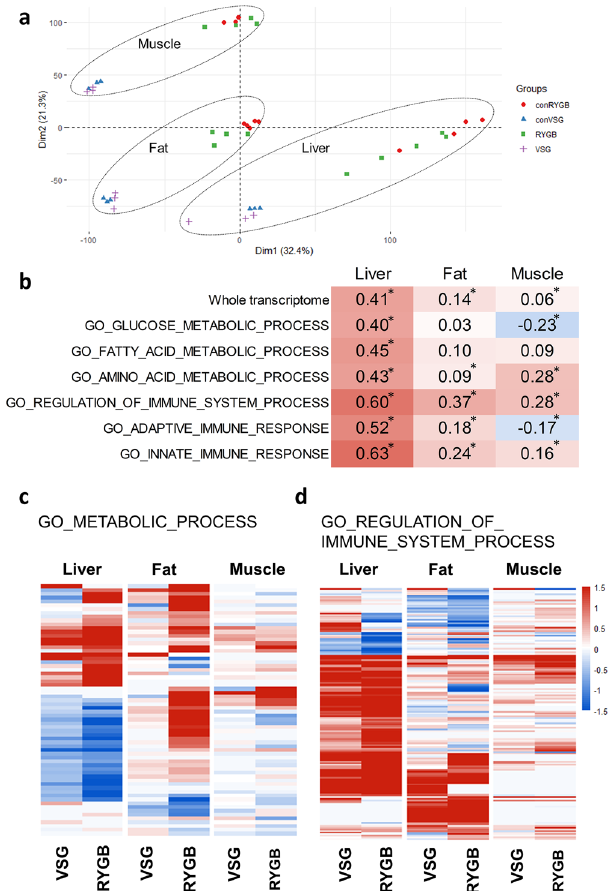
Figure 4. The comparison of gene expression profile between the VSG and RYGB model. ( a ) PCA plot of the VSG and RYGB model and their respective control groups. conRYGB, weight-matched control mice of the RYGB mice; conVSG, pair-fed control mice of the VSG mice. ( b ) Correlation between the gene expression changes of the VSG and RYGB model. Red indicates a positive correlation, while blue indicates a negative correlation. ‘*’ denotes significant by P value < 0.05. All other correlations were significant with P value < 0.001. The expression patterns of the genes of the ( c ) metabolic process and ( d ) the immune system process in the VSG and RYGB model. Heatmap shows log 2 fold change. Each row represents a gene. Any genes that showed adjusted P value < 0.05 in any of the three organs are included in the